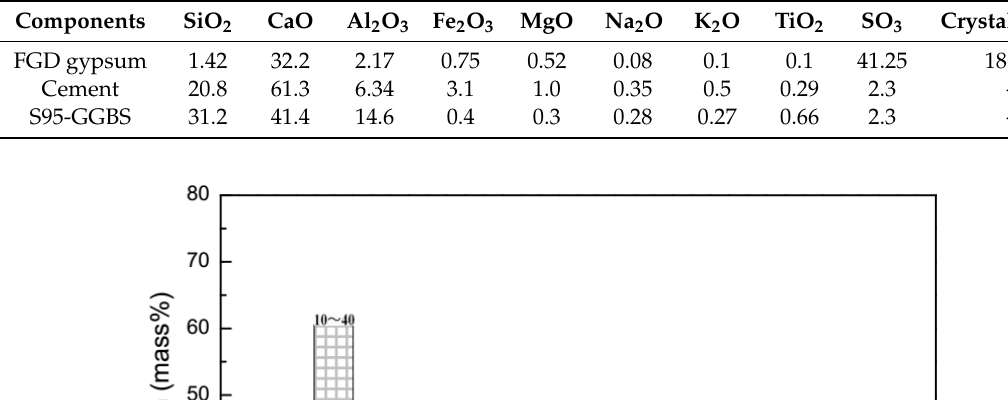
Table 1. Chemical compositions of raw materials (wt.%).